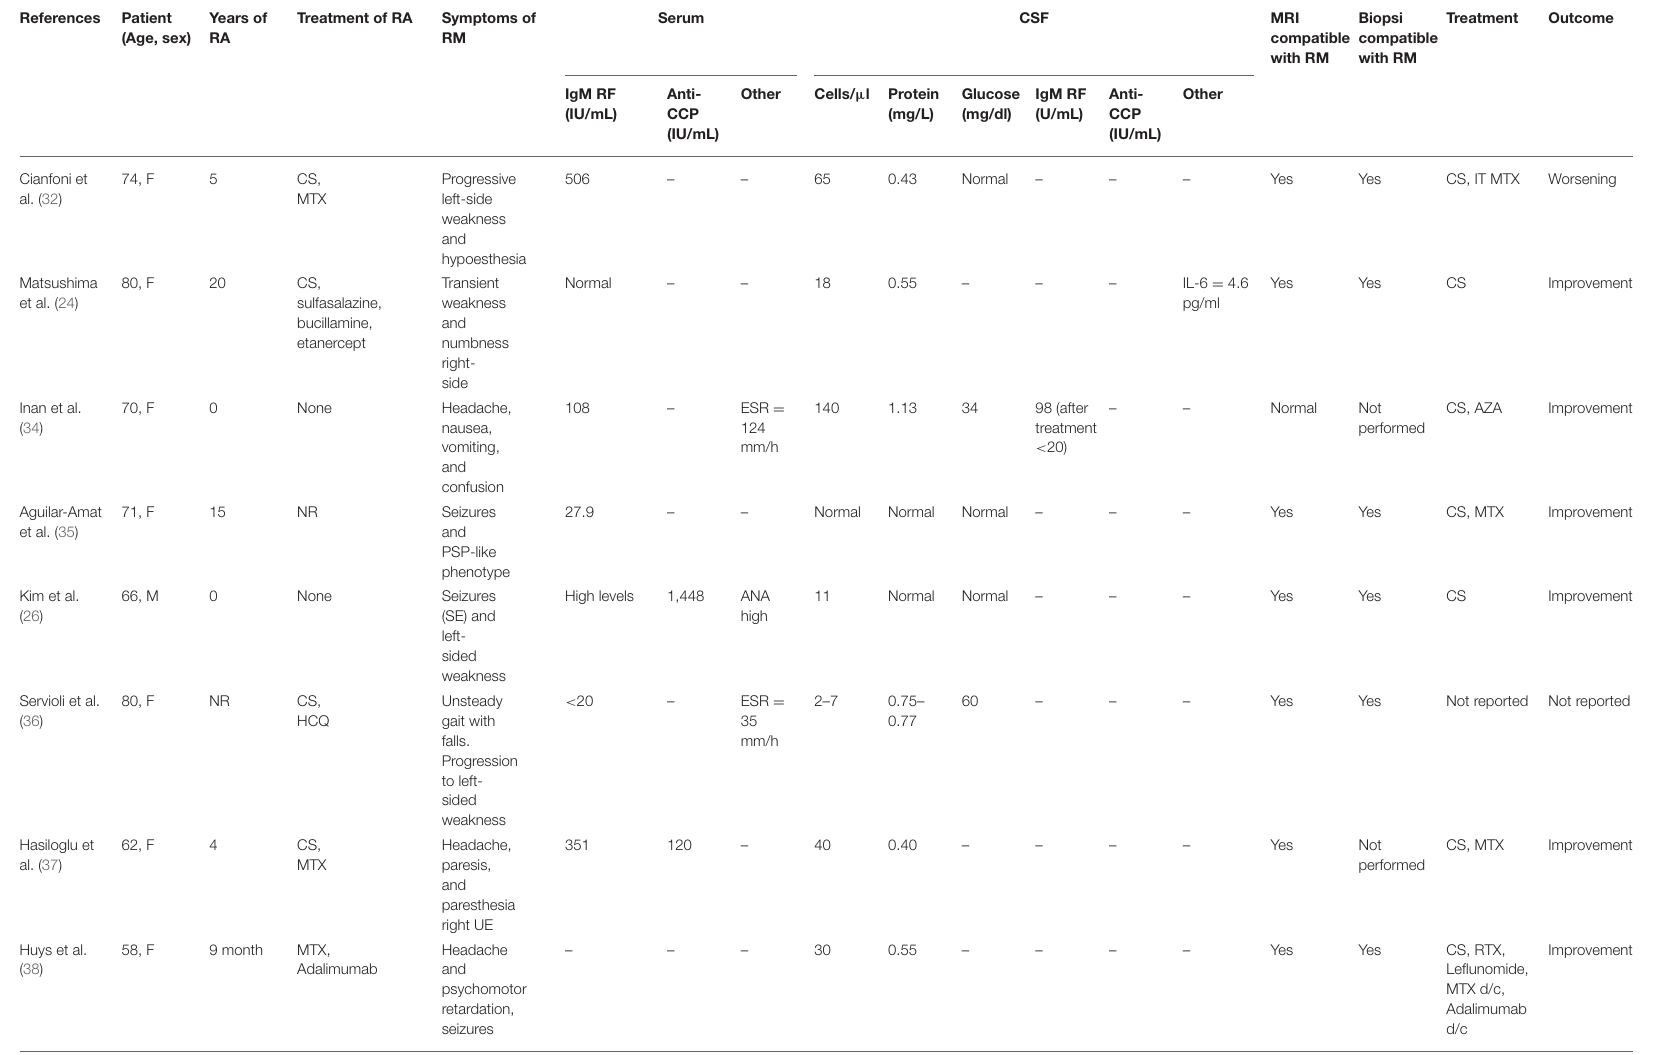
TABLE A1 | Summary of RM cases from 2010 to